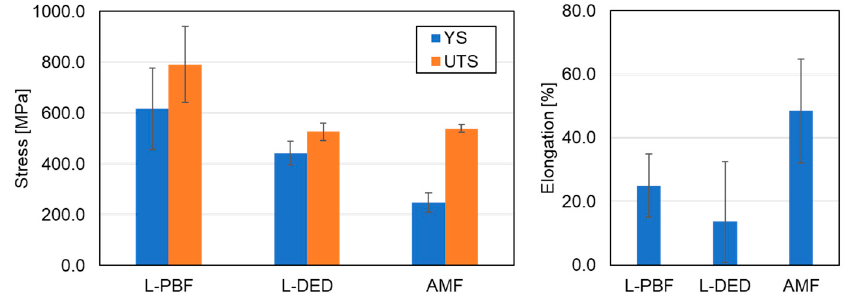
Figure 19. The e ff ect of di ff erent AM technologies on tensile strength of Al 0.3 CrFeCoNi HEA in terms of YS, UTS and elongation. L-PBF [53,105], L-DED [145,146], AMF [247,248]. of YS, UTS and elongation. L-PBF [53,105], L-DED [145,146], AMF